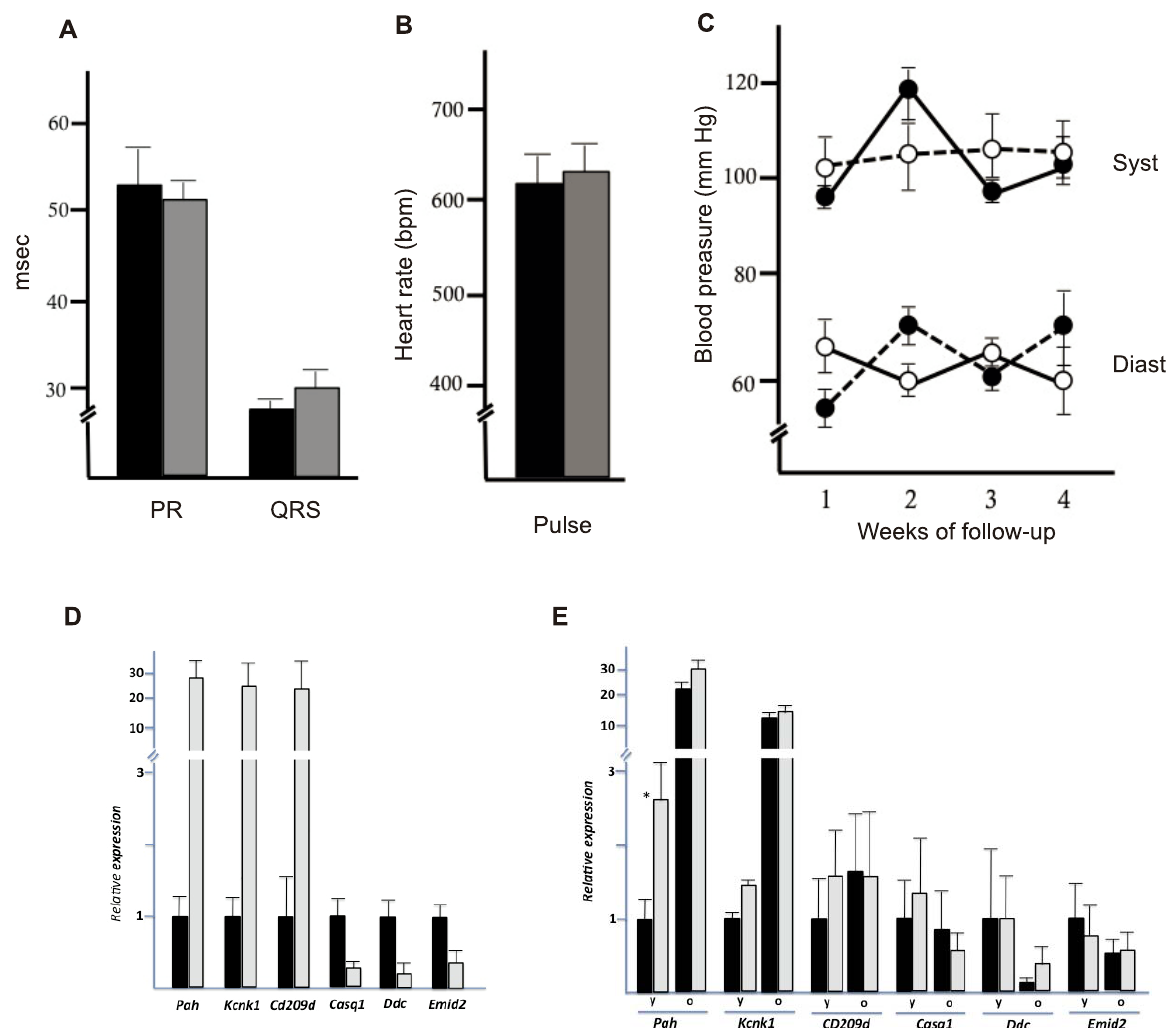
Figure 2. Heart molecular signature and cardiovascular phenotype of Pol m 2 / 2 mice. ( A–C ) Cardiovascular parameters in old Pol m 2 / 2 (gray) and wt (black) mice (16–18 m). ( A ) Electrocardiographic parameters; QRS complex and PR segment intervals are shown in miliseconds (msec). ( B ) Heart rate (beats per minute; bpm). Data are means 6 SD of weekly readings collected over a 4-week period. ( C ) Systolic and diastolic blood pressure (mm Hg) in wt (black) and Pol m 2 / 2 mice (white) over a 4-week period. Results are means 6 SD (n=3 mice). ( D ) After DNA array expression analysis of hearts from old (20–24 m) and young (3–4 m) wt mice, six genes showing an aging-related profile were selected and confirmed by qRT-PCR. Data from old mice (black) are presented relative the expression level of each gene in young mice (gray). ( E ) Comparative gene expression analysis in young (y; 8–12 weeks) and old (o; 20–24 m) heart tissue from wt (black) and Pol m 2 / 2 mice (gray). Data were normalized to the expression level of each gene in young wt mice. Results, expressed as 2 ‘ –(DCT), are mean values 6 SD